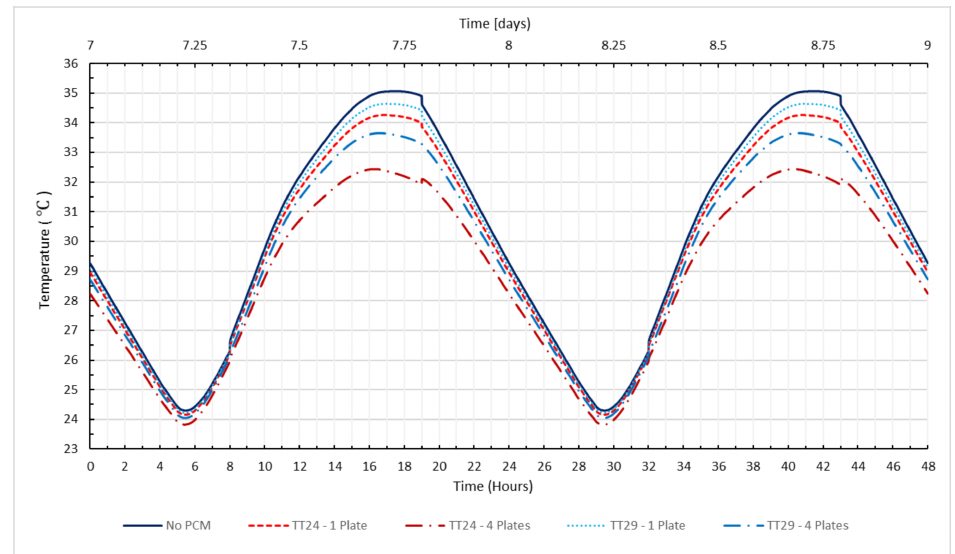
Figure 7. Indoor temperatures for the room with low thermal inertia, for the cases of no PCM, PCM with transition / melting temperature of 24 ◦ C, and transition / melting temperature at 29 ◦